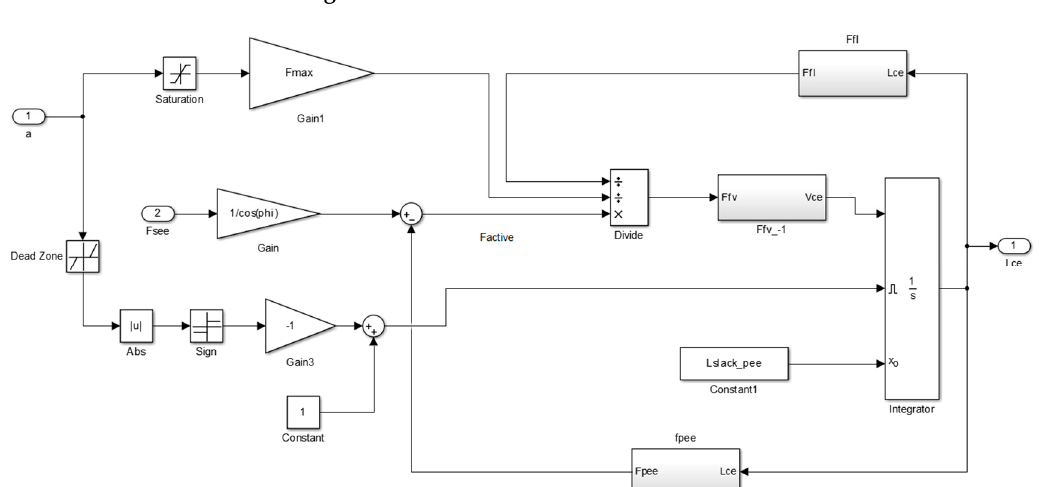
Figure A.4. Block diagram representing the contractile element’s length (Lce)